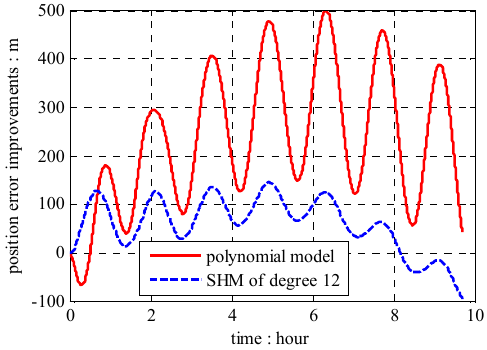
Figure 15. Square root of position error components.